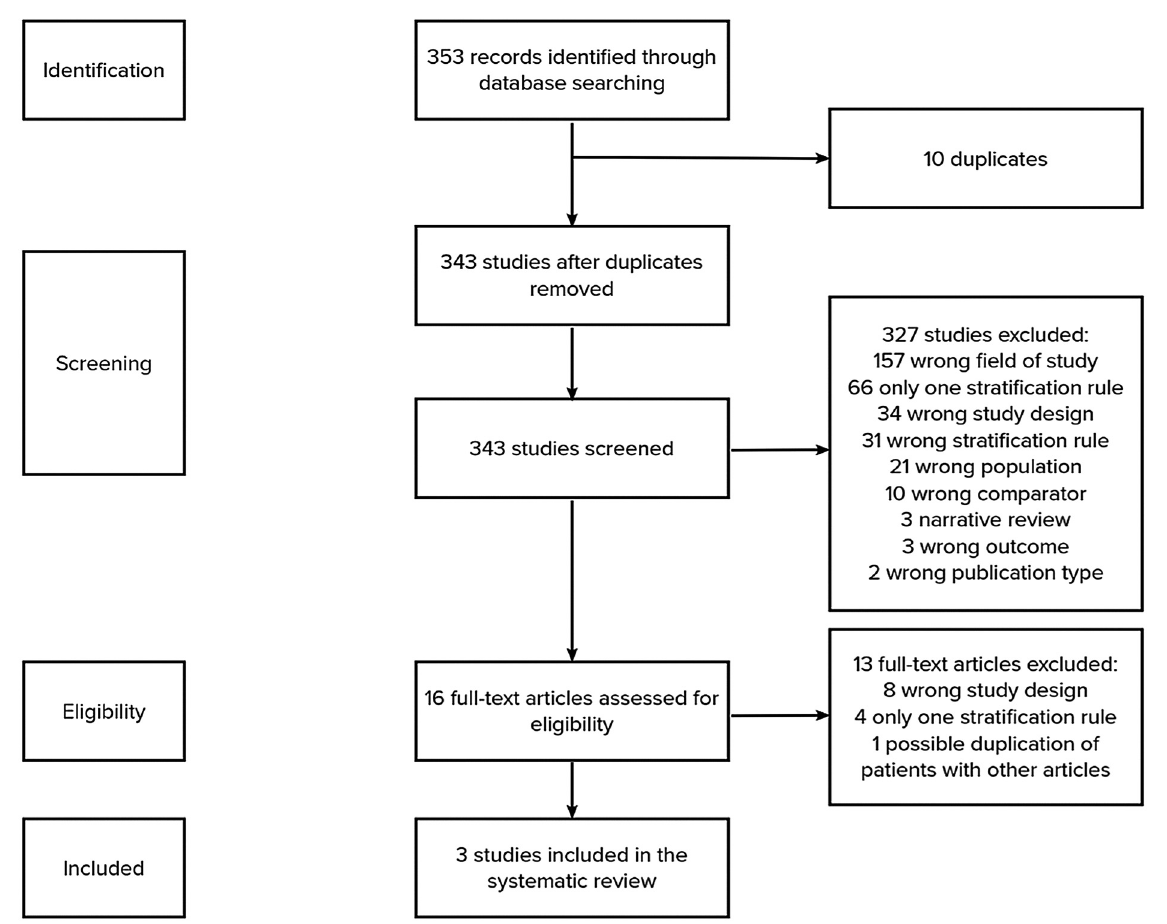
Fig. 1 Flowchart outlining the protocol adopted in this systematic